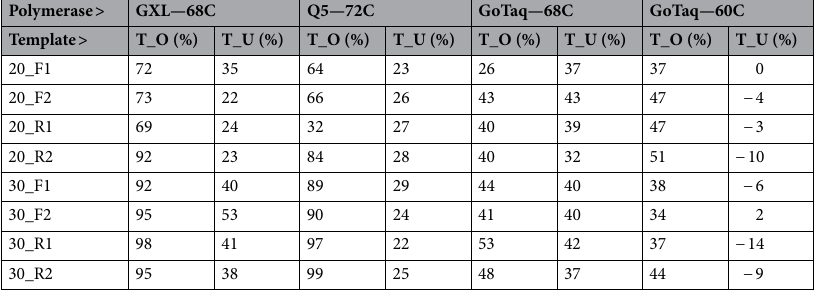
Table 4. LNA blocking as a function of DNA polymerase. Eight blockers with moderate to high blocking effectiveness were evaluated with three different polymerases using the indicated extension temperatures. The manufacturers’ suggested buffer and cycling conditions were used for each polymerase except for when GoTaq was used with a 60 °C extension. Blocking was attempted with both Template_0 that contains a specific binding site and Template_U which did not contain any site recognizable by these blockers. Both templates were amplified using primers F1 and R1 with LNA added to 1